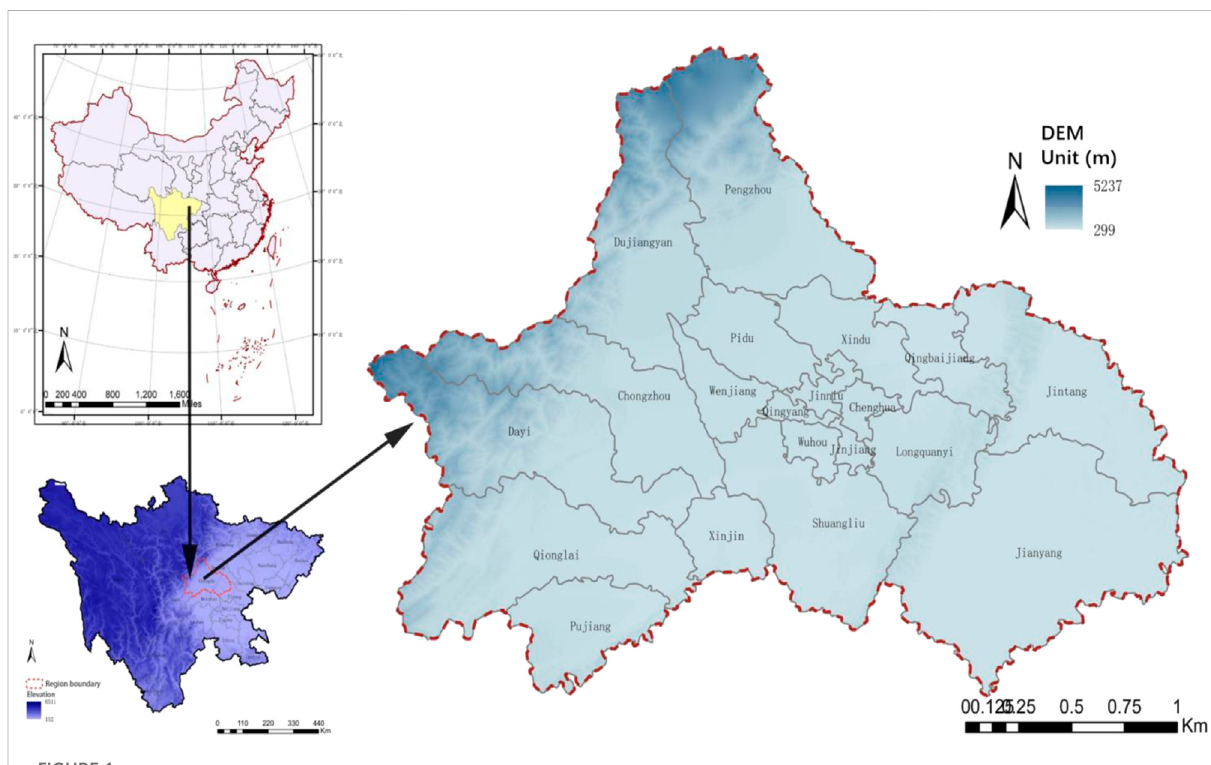
FIGURE 1 Location of